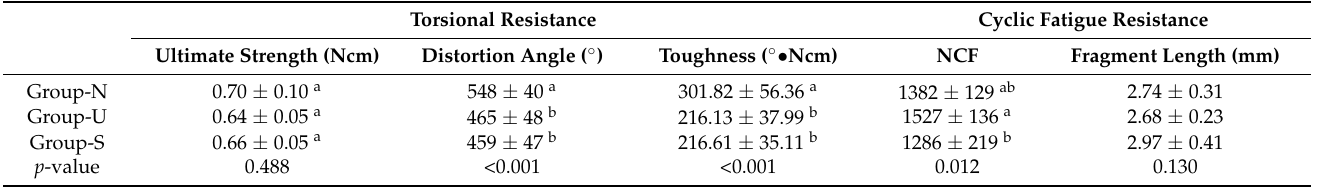
Table 1. Torsional and cyclic fatigue resistance of the tested NiTi